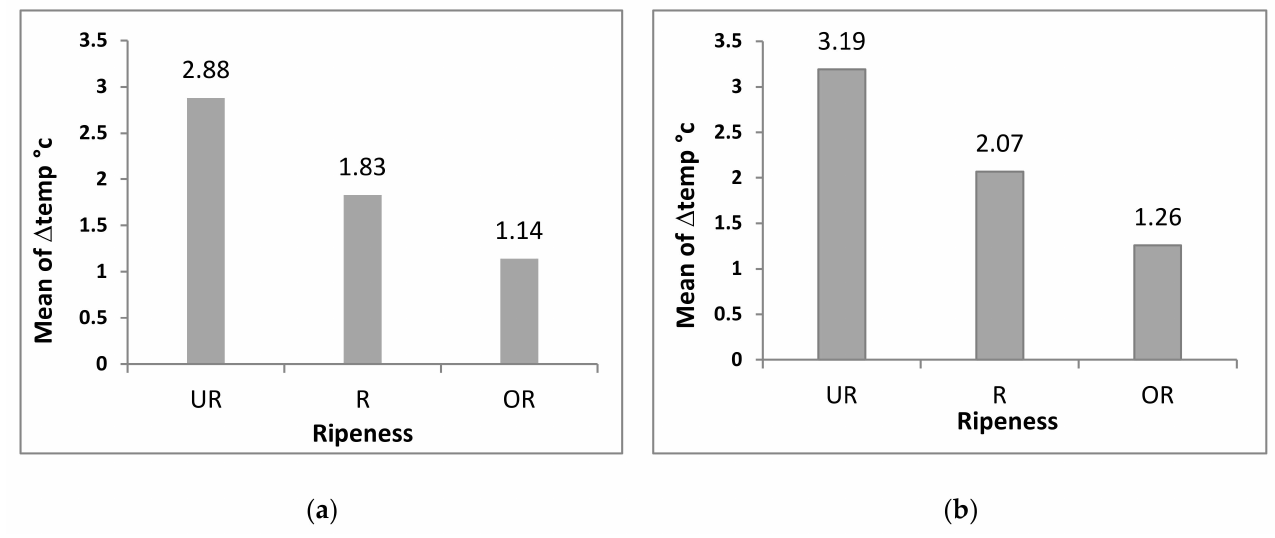
Figure 10. Mean values of ∆ Temp based on different ripeness categories: ( a ) first experiment, ( b ) second